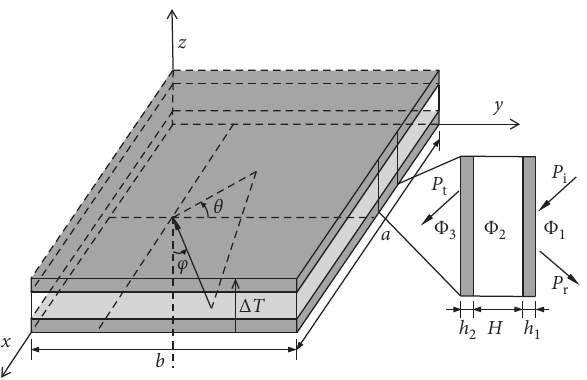
Figure 1: Schematic illustration of a simply supported double- panel partition under the thermal